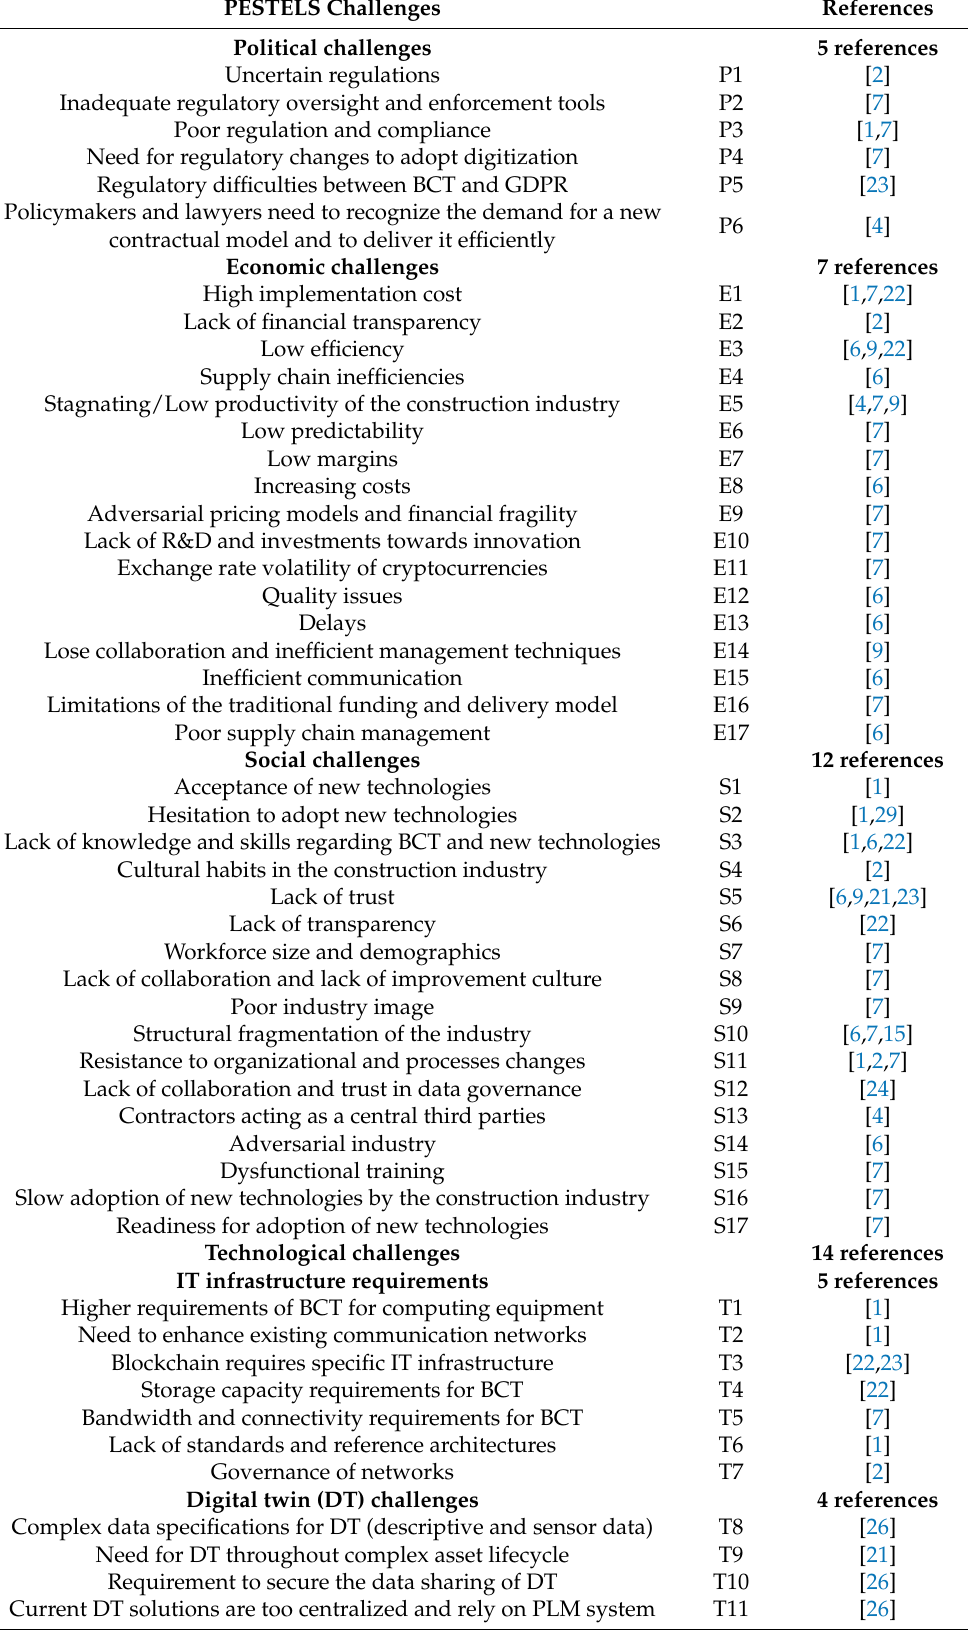
Table 1. Summary of the challenges related to BCT adoption in the BECOM industry